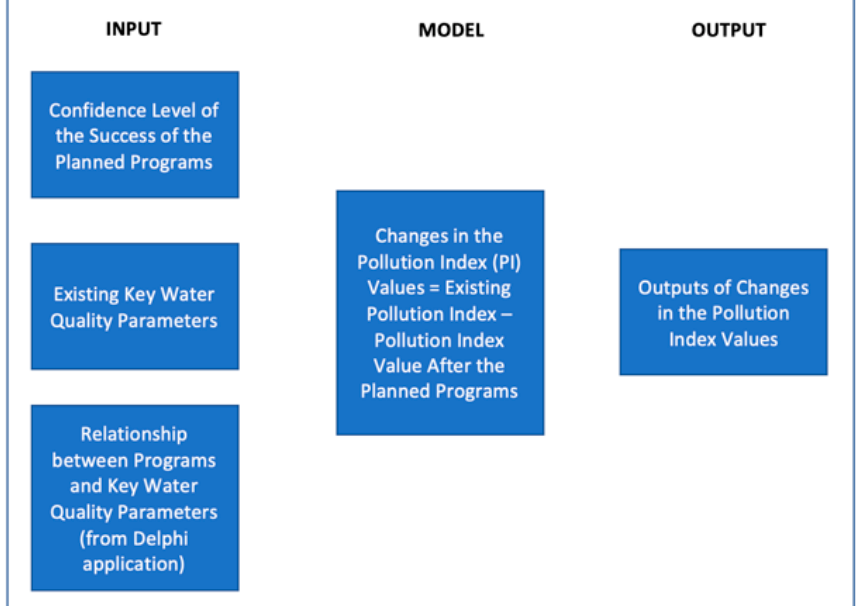
Figure 4. Framework for the Monte Carlo simulation.